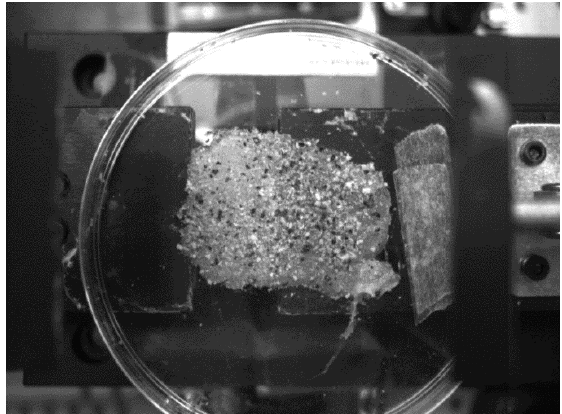
Figure 11. Image of bio-tissue rigid body translation experiment.